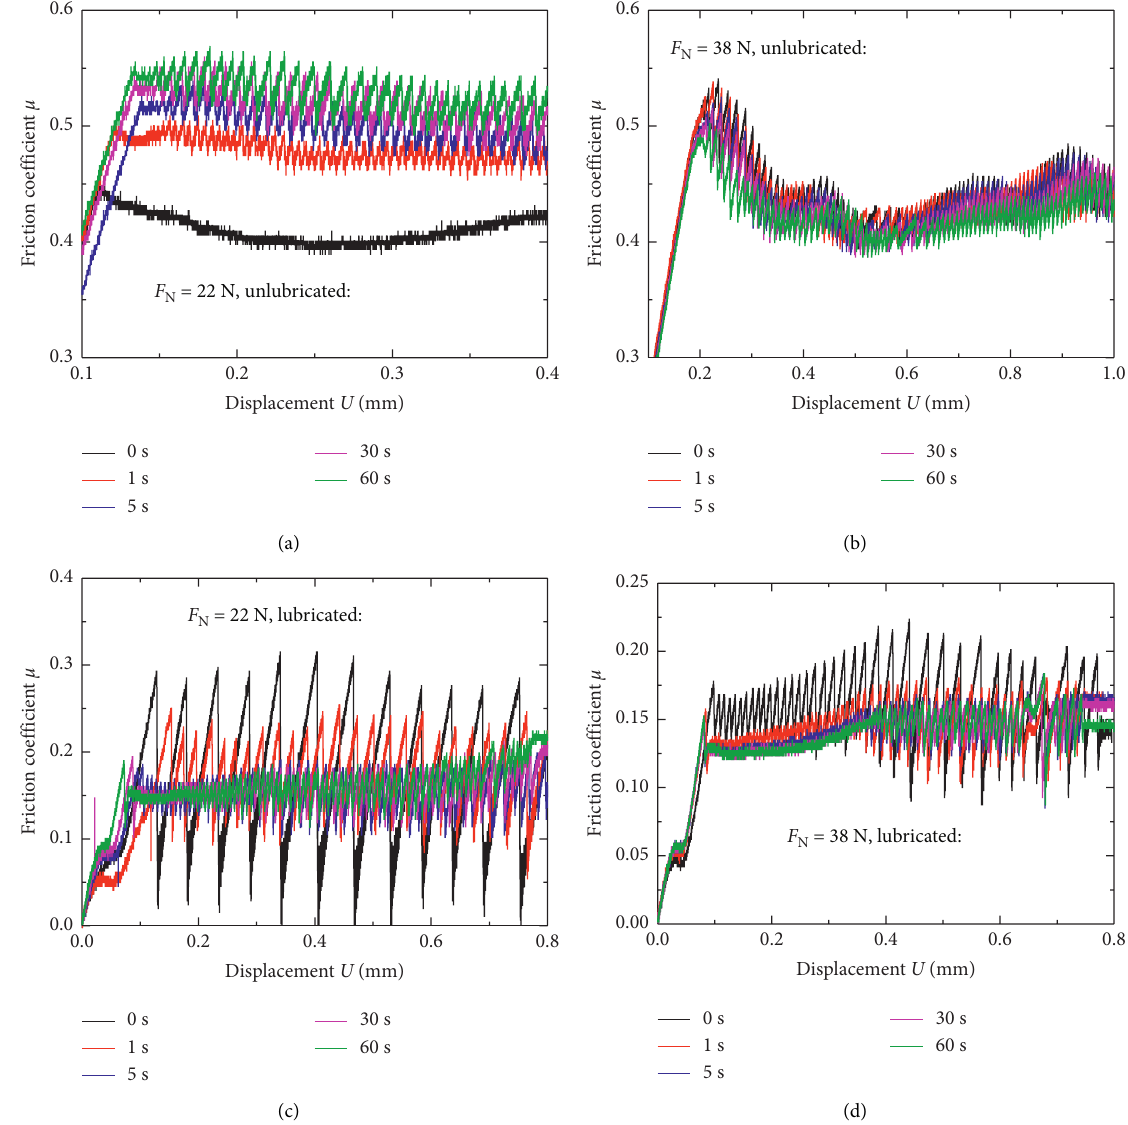
Figure 5: Effect of quiescent time on the transition from static to kinetic friction ( V � 22 . 78 μ m/ s )